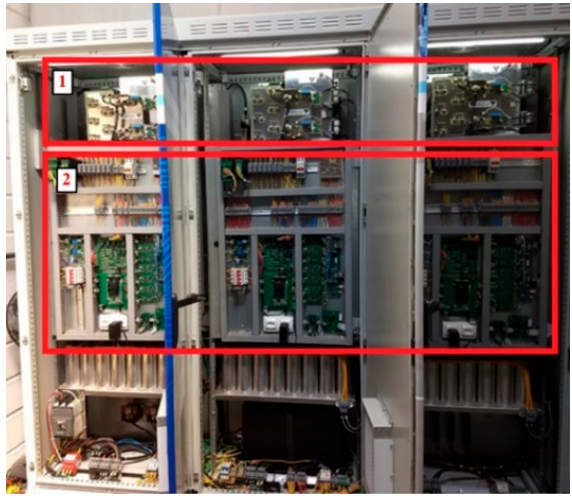
Figure 9. Inner electronics of the series VSC.